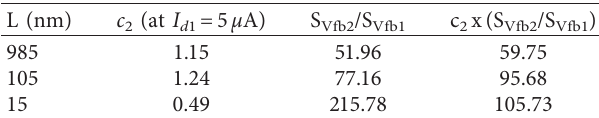
Table 3: Data of coupling factor c 2 weighted by S Vfb2 / S Vfb1 for various gate lengths (Uncertainty estimation: ±